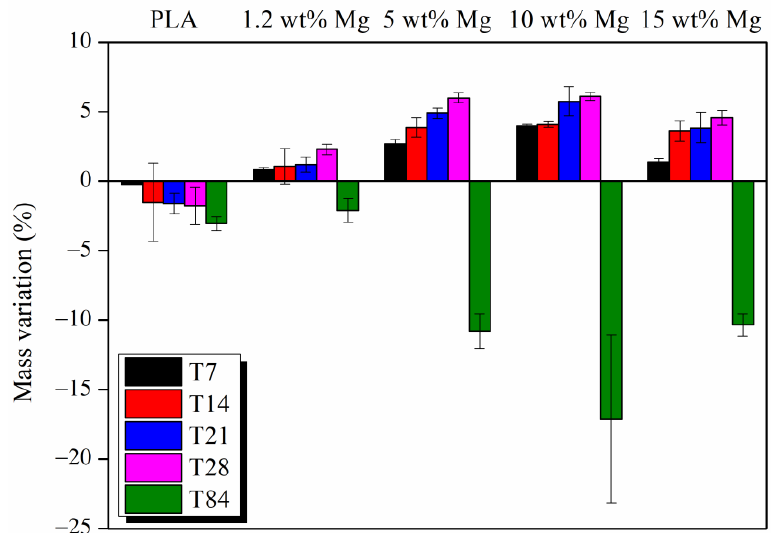
Figure 13. Percentage of mass variation in PLA-Mg filaments after 7, 14, 21, 28, and 84 days in PBS media.